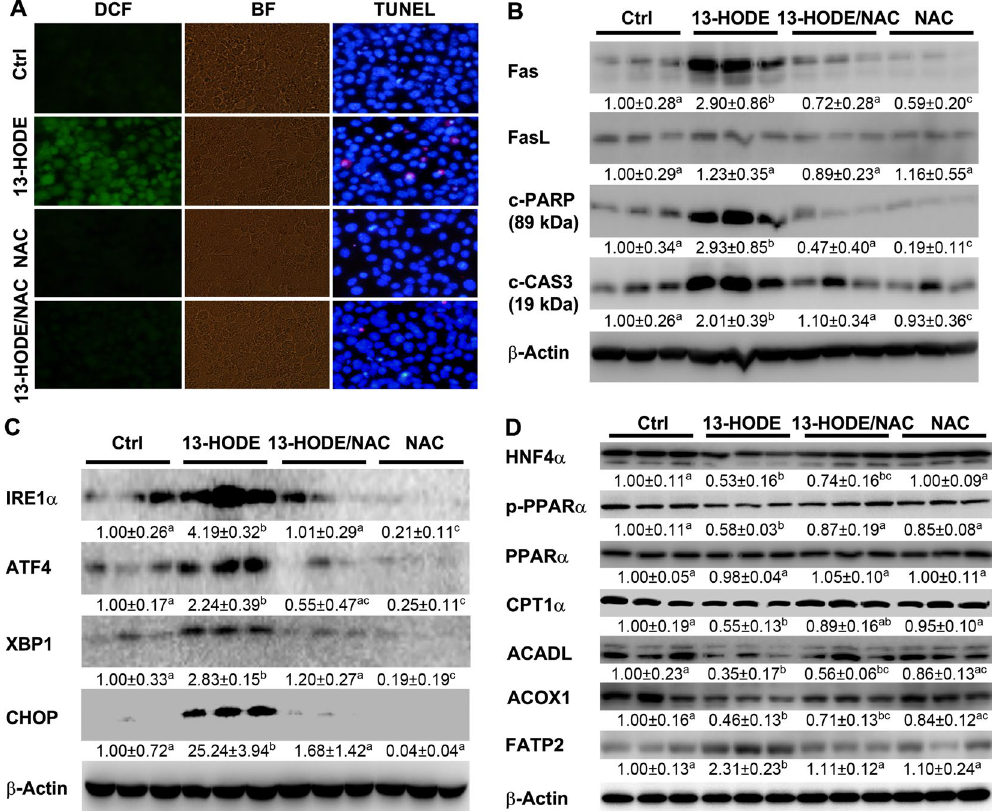
Figure 2. 13-HODE induced ROS production, ER stress, perturbation of lipid metabolism, and apoptosis in Hepa-1c1c7 cells. Hepa-1c1c7 cells were treated with 13-HODE at 1 μ M in the presence or absence of NAC at 10 mM for 3 days. ( A ) ROS production was analyzed by DCF staining (left panel) and apoptosis was analyzed by TUNEL staining (right panel). ( B ) Immunoblot of proteins involved in apoptosis. ( C ) Immunoblot of proteins involved in ER stress. ( D ) Immunoblot of proteins involved in lipid metabolism. Protein levels were quantitated by NIH image J. All values are denoted as means ± SD (n = 3). Significant differences were indicated by different letters (ANOVA, P < 0.05). DCF: 2 ′ ,7 ′ -dichlorodihydrofluorescein diacetate, BF: bright field, TUNEL: terminal deoxynucleotidyl transferase dUTP nick end